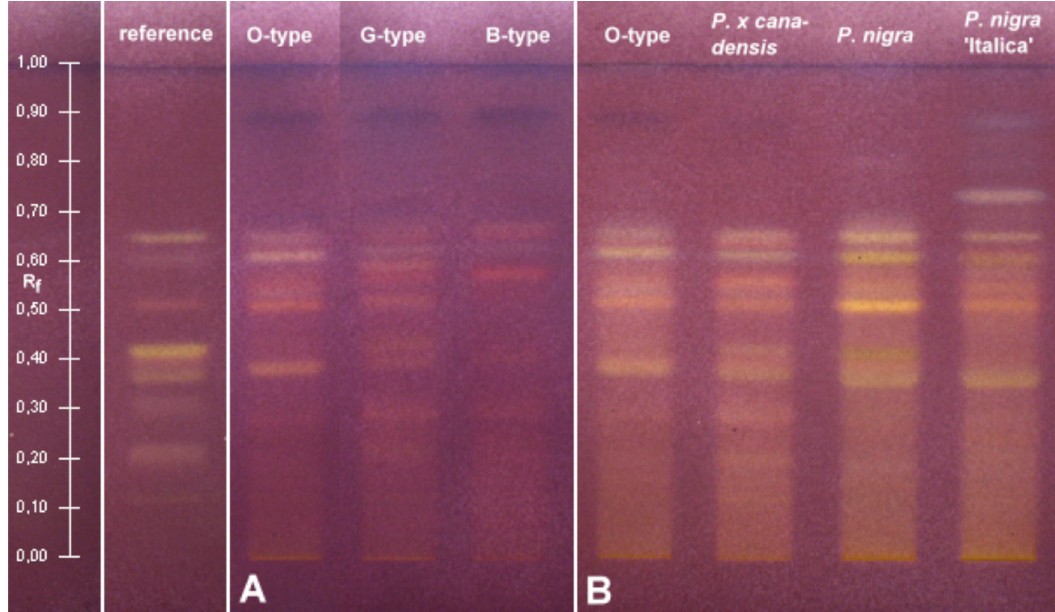
Fig. 6: TLC fingerprints of the DPPH experiment with (A) the three propolis types in comparison and (B) the O-type propolis with P. nigra L. ssp. nigra , P. x canadensis Moench ‘Robusta’ and P. nigra L. ‘ Italica’ bud extracts (each 20 μL). The applied volume for the reference was 40